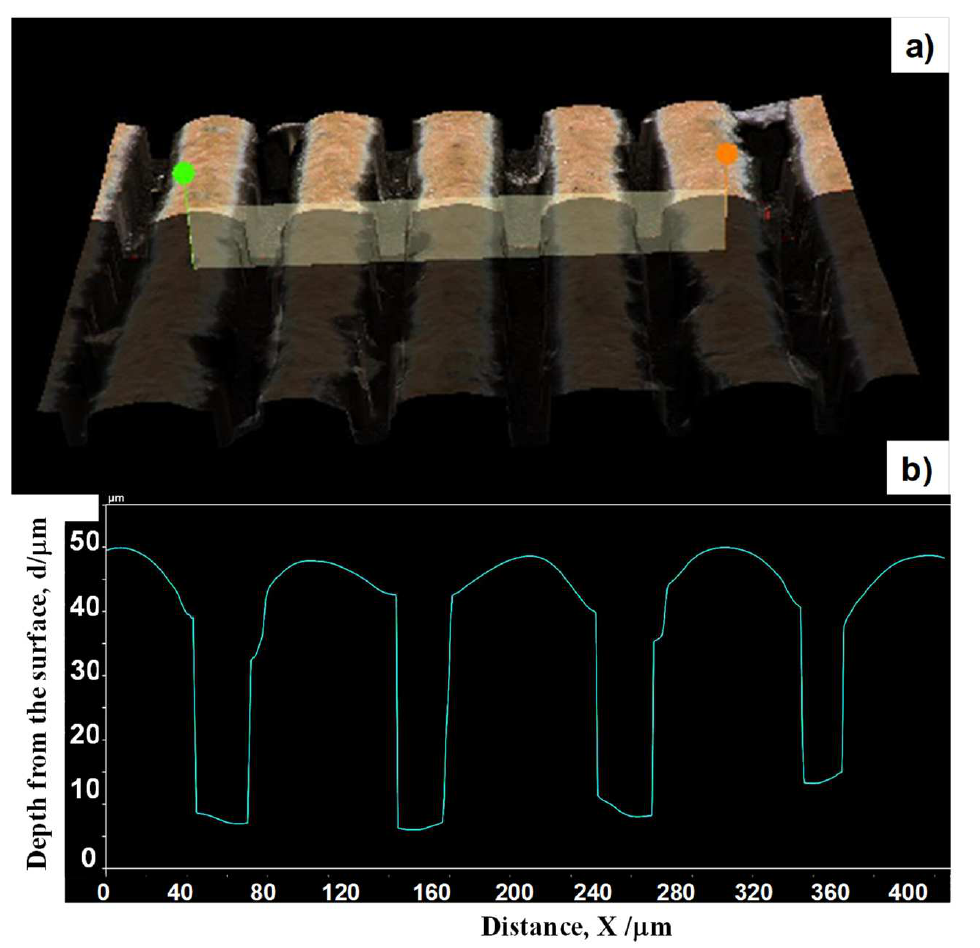
Figure 10. The depth profile of the micro-grooved VGS, shown in Figure 9a, was measured by laser microscopy. ( a ) Overview of micro-grooved VGS-1, and ( b ) cross-sectional depth profile of micro-grooved VGS-1.